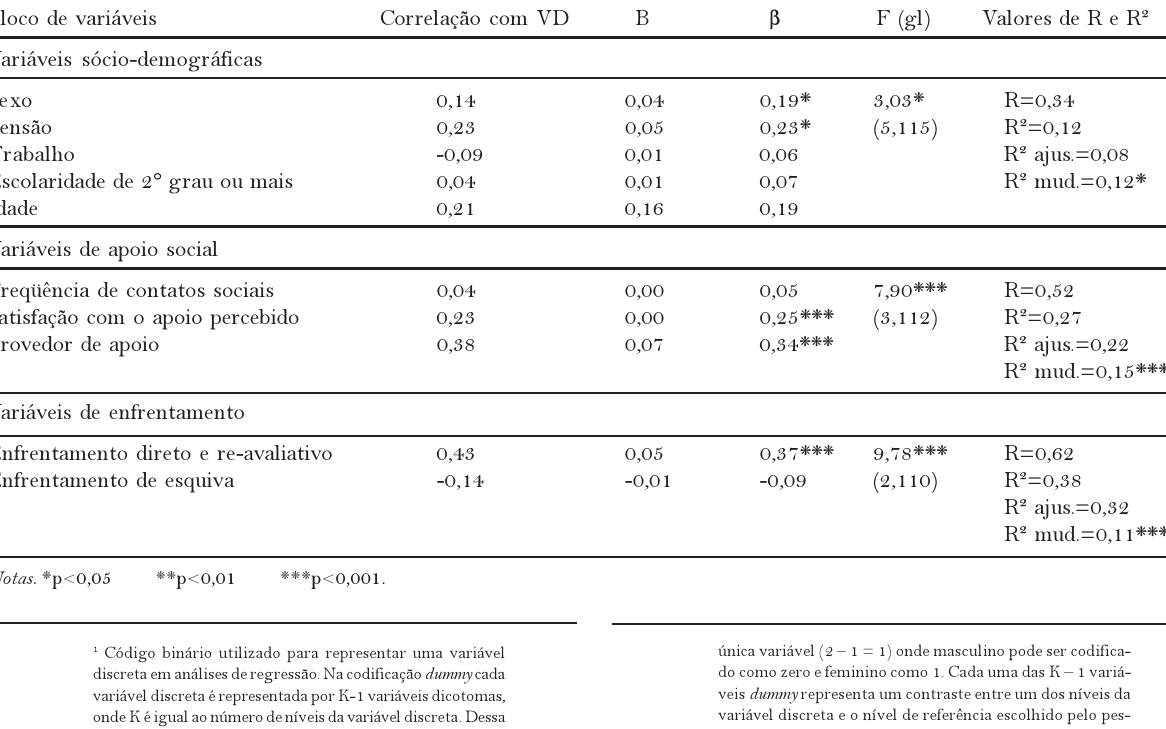
social) foram incluídas as variáveis: freqüência de conta- tos sociais, satisfação com o apoio recebido e apoio que o idoso provê aos demais (variável dummy). No terceiro e das as variáveis: enfrentamento direto e re-avaliativo e enfrentamento de